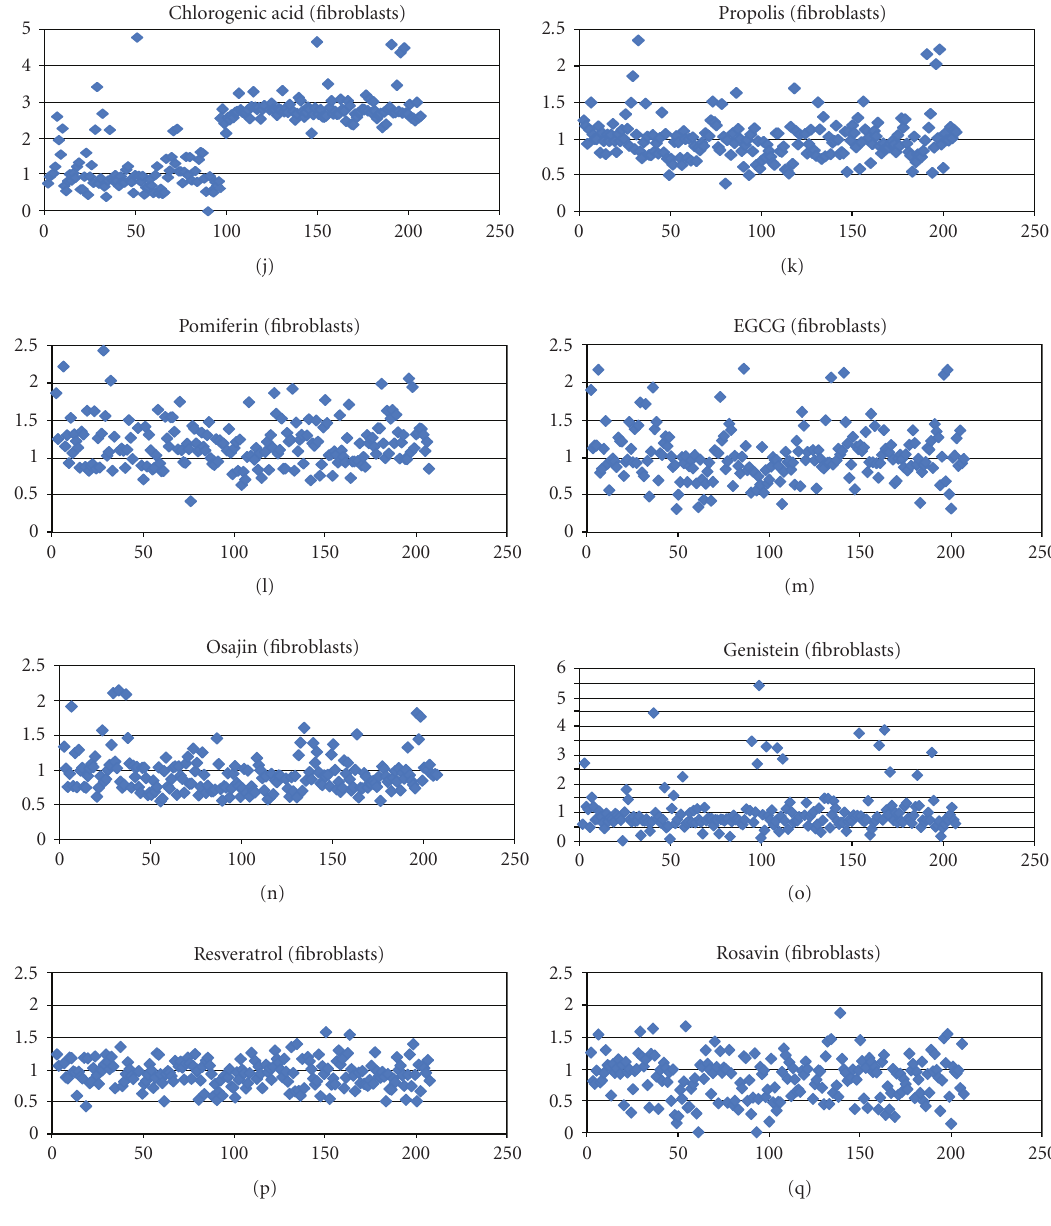
Figure 2: Ratio of Medians for genes shown in Table 2 for all individual product treatments on NHEK and NHDF.